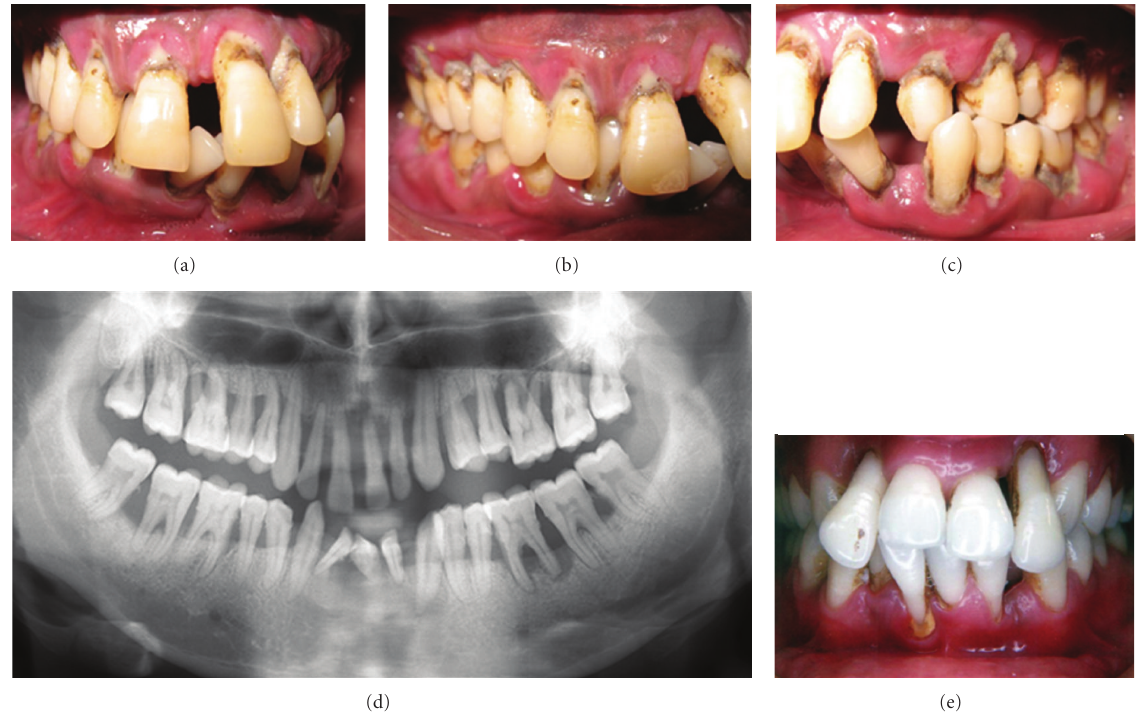
Figure 2: (a)–(d) Clinical and radiographic appearance of GAgP in a 25-year-old smoker with poor oral hygiene. (e) A 19-year-old smoker with GAgP demonstrating severe periodontal destruction.